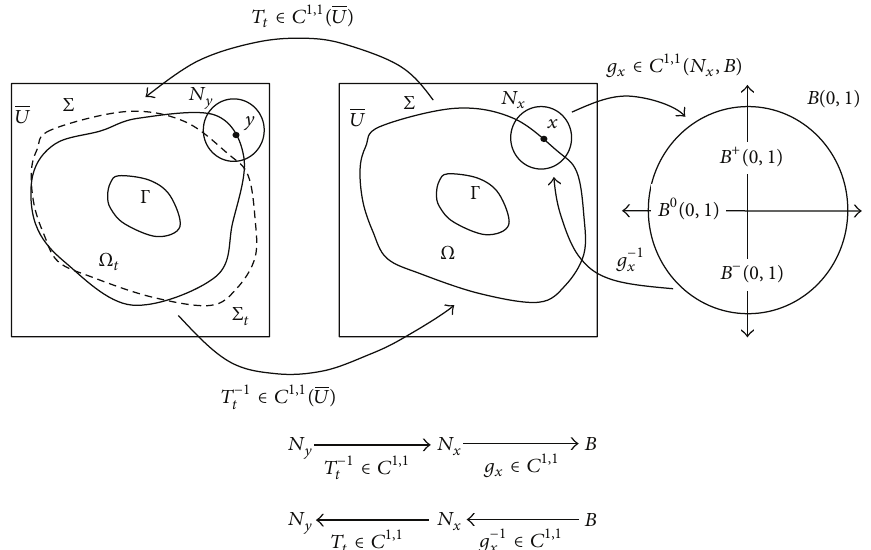
Figure 3: The action of 𝑇 𝑡 on a 𝐶 1,1